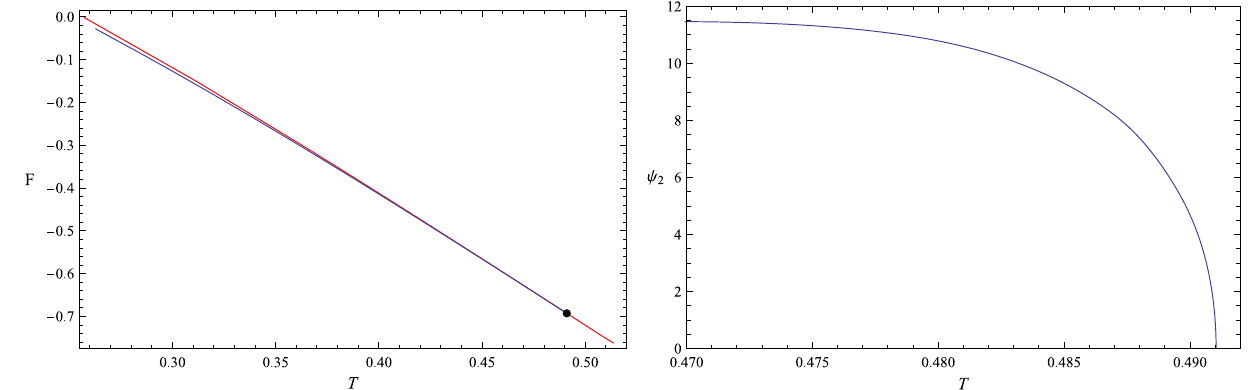
Fig. 3 We plot the free energy as a function of the temperature in the left panel with q = 100, m 2 = 0, μ = 0 . 15 and the right panel is for the behaviors of ψ 2 . The solid blue line represents the hairy black hole